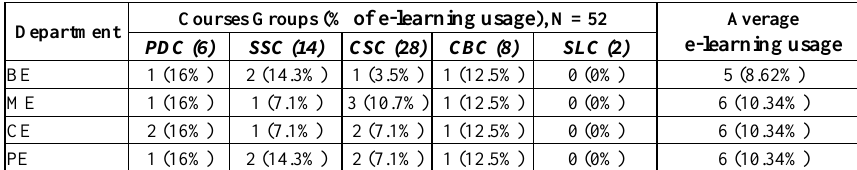
Table 4. The use of e-learning in